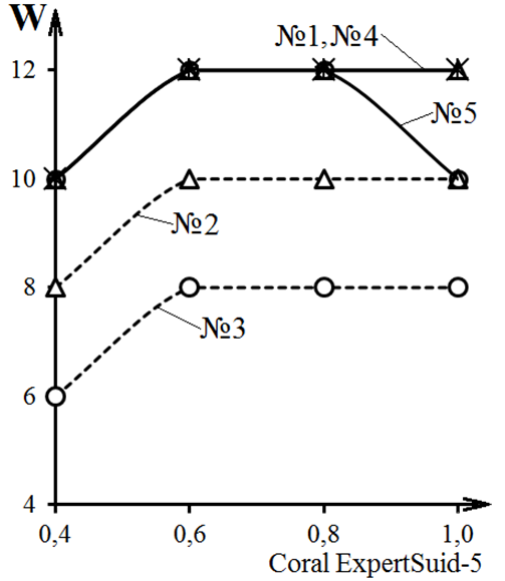
Figure 3. The effect of the amount of plasticizer and the type of sand on the water tightness of lightweight expanded clay